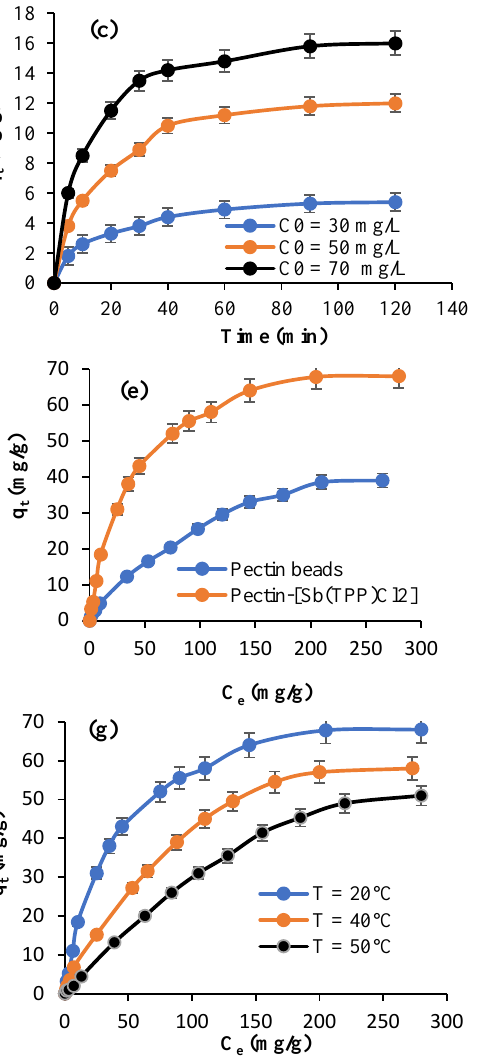
Figure 6. ( a ) Change of [Sb(TPP)Cl 2 content (pH = 6, T = 20 °C, C 0 = 30 mg/L, and time = 90 min), ( b ) pH value (T = 20 °C, time = 90 min, C 0 = 30 mg/L), ( c , d ) time change for plain beads and composite beads, respectively (T = 20 °C, pH = 6), ( e ) dye concentration change (T = 20 °C, time = 90 min, and pH = 6), and ( f , g ) temperature change for pectin and composite beads, respectively (time = 90 min and pH = 6).